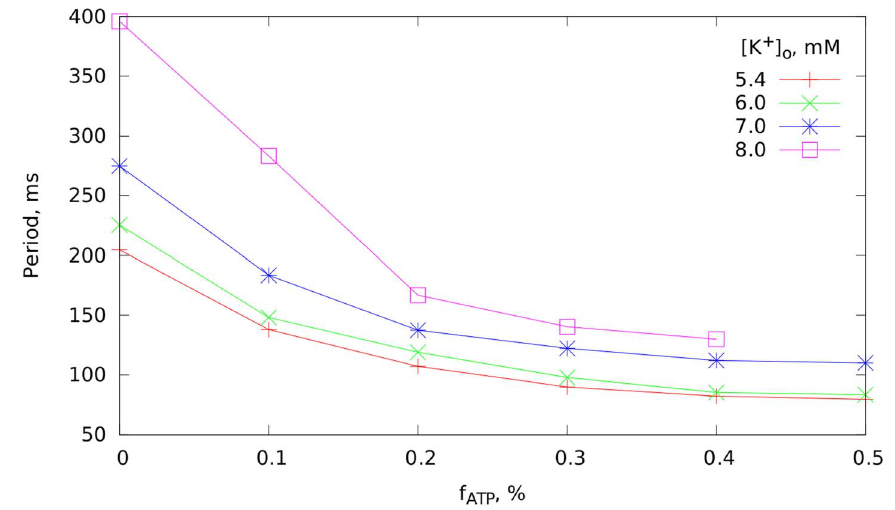
Figure 5. The effect of hyperkalemia and hypoxia on period of simulated VF in anatomically detailed 3D model.